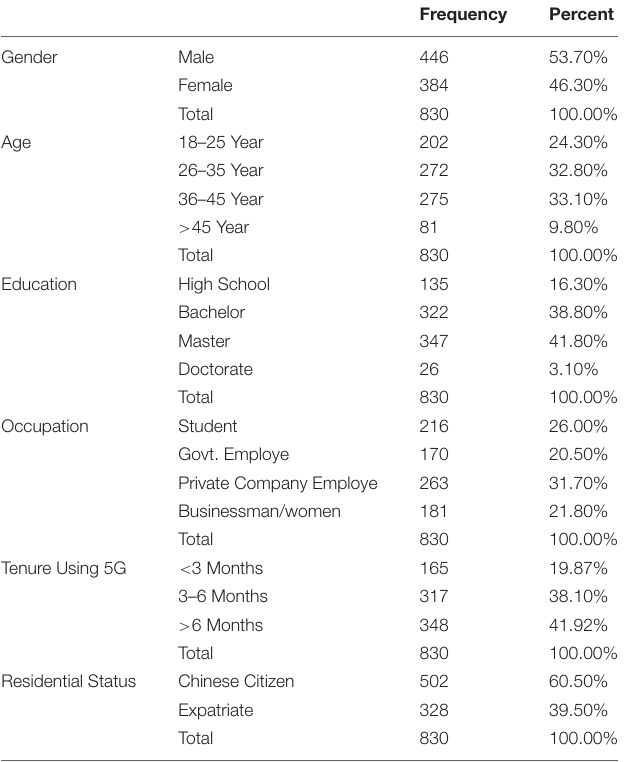
TABLE 1 | Demographic profile of the